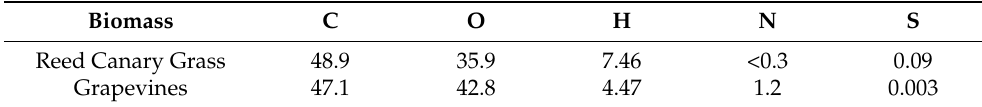
Table 1. Composition of biomasses in wt.% (dry mass).